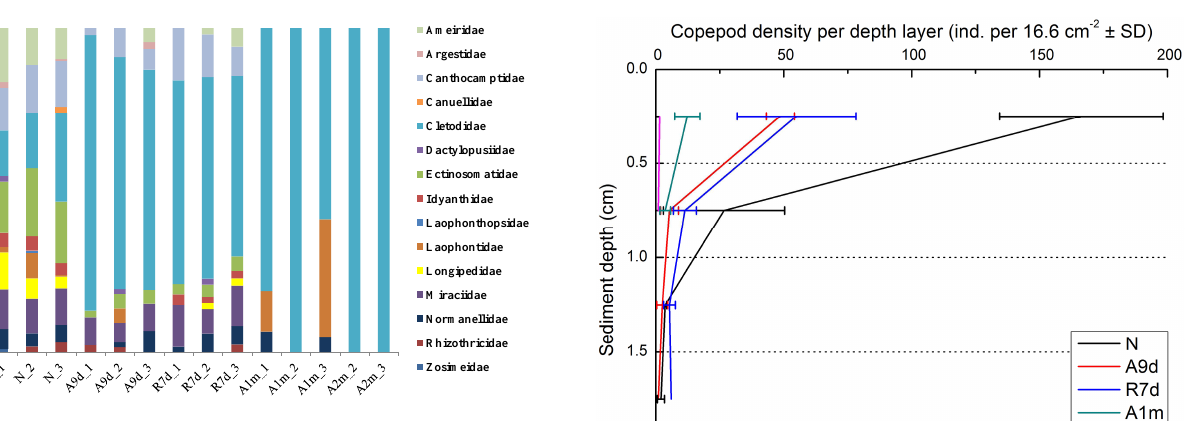
Fig. 4. Relative composition of copepod families in the different replicates (three per treatment, only 2 replicates for the 2-month treatment). N = normoxia, A = anoxia, R = recovery, duration of treatment: 7days, 9days, 1month, 2months, replicates indicated by 1, 2, 3. Families listed alphabetically, and plotted in the column in same order. Table 2. Number of gravid females (sum of all cores) of various families and number of copepodite stages (sum of all cores), in dif- ferent treatments. Gravid females were absent in 2-month and 10- month anoxia treatments. Relative amount of females (F) and males (M) averaged over three replicates is also given (note in 2-month anoxia calculated from 4 individuals present in two replicates). N = normoxia, A = anoxia, R = recovery, duration of treatment: 7days, 9days, 1month, 2months.